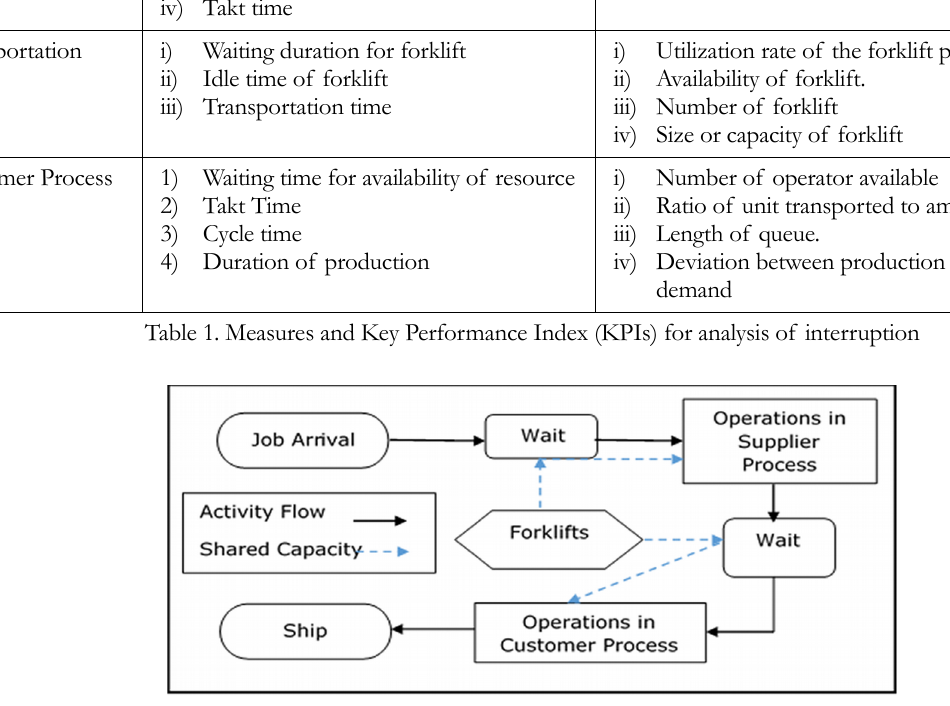
Figure 4. Conceptual model of production system in the